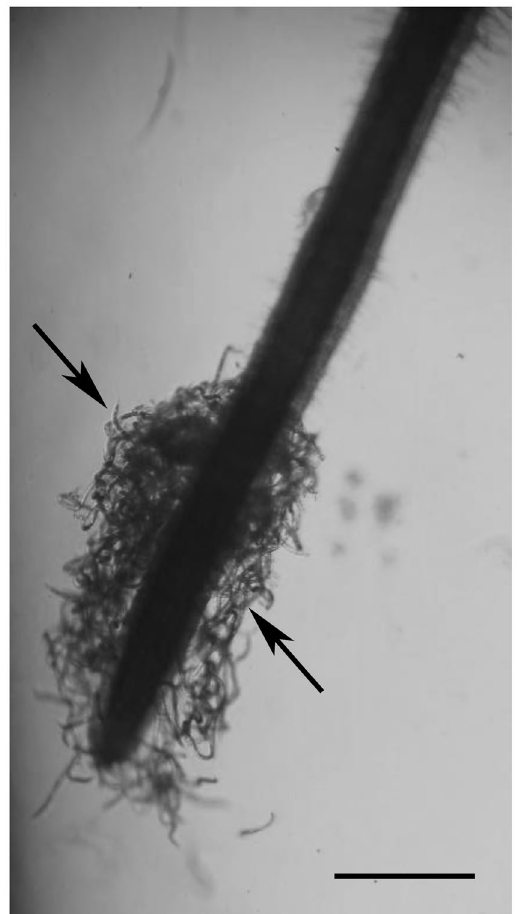
Figure 1. Attraction of Heterodera avenae juveniles to the root tips of Wenmai 19 wheat. The figure shows the aggregation of H. avenae juveniles (indicated by arrows) around a wheat root tip when nematodes and wheat roots were incubated together in a Pluronic F-127 gel for 3 hours (scale bar = 1